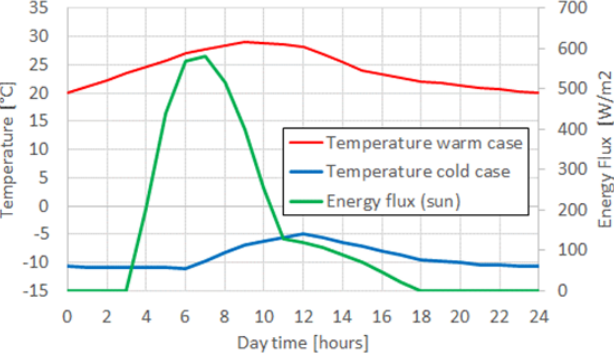
Figure 4. Boundary conditions on the exterior wall surface.